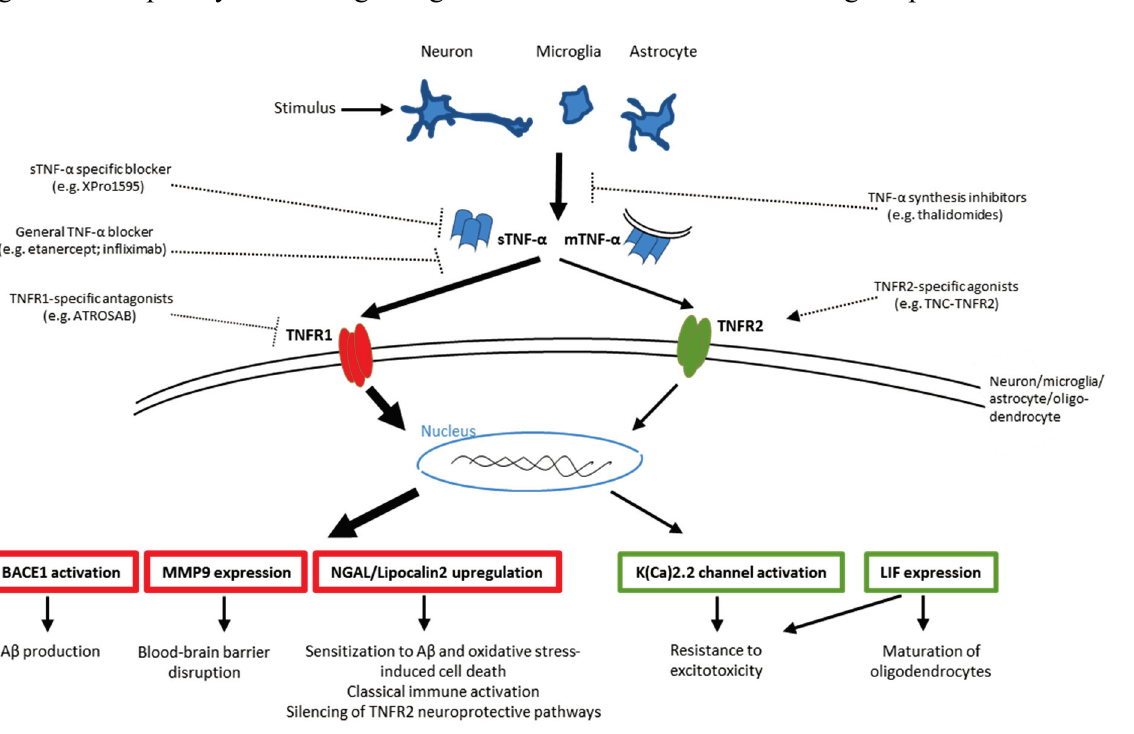
Figure 3. Examples of specific downstream targets of TNFR1 and TNFR2 that may be involved in neurodegenerative disorders. Dotted lines indicate existing potential therapeutic approaches. Other general TNF- α blockers, not depicted in this figure, include adalimumab, certolizumab pegol, and golimumab. Other new TNFR1-specific antagonists include DMS5540 and TROS (also see review by Fischer et al ., 2015